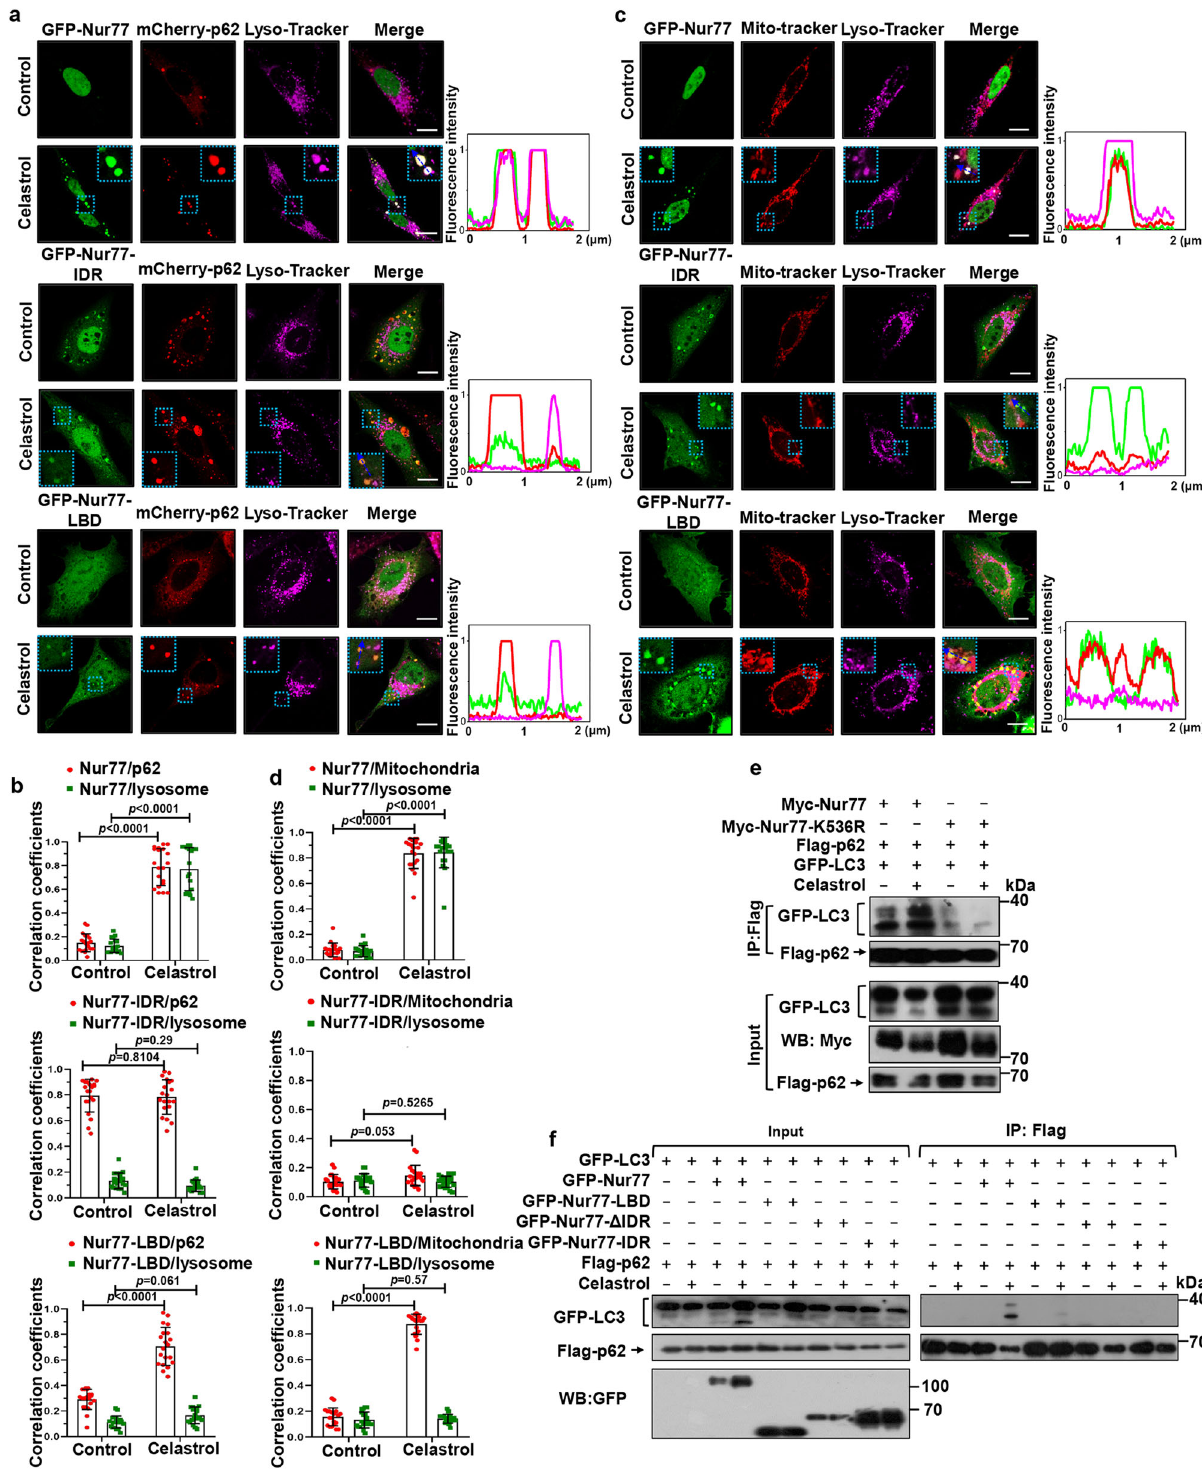
Fig. 6 Nur77-LBD is insuf fi cient to mediate celastrol-induced mitophagy. a – d Representative images showing colocalization of Nur77 or mutants with p62, mitochondria, and lysosome in HeLa cells after celastrol treatment. The blue arrow indicates line pro fi les of fl uorescence intensities including Pearson ’ s correlation coef fi cients shown in b and d . A two-tailed unpaired Student ’ s t -test was used for statistical analysis, and data were presented as mean values ± SEM ( n = 20 biologically independent samples). Dotted box: higher magni fi cation of indicated region. Scale bar, 10 μ m. e Mutating K536 in Nur77 inhibits celastrol-induced interaction between p62 and LC3. HeLa cells transfected with the indicated expression plasmids were treated with or without 2 μ M celastrol and 20 ng/mL TNF α . Interaction of Flag-p62 with GFP-LC3 was examined by co-IP assay. f Characterization of domain requirement of Nur77 for promoting celastrol-induced p62 interaction with LC3. HeLa cells transfected with the indicated Flag-p62, GFP-LC3, and GFP-Nur77 or mutant were treated with celastrol and TNF α for 1 h and analyzed for Flag-p62 interaction with GFP-LC3 by co-IP assay. Data represent at least three independent experiments. Source data are provided as Source Data fi